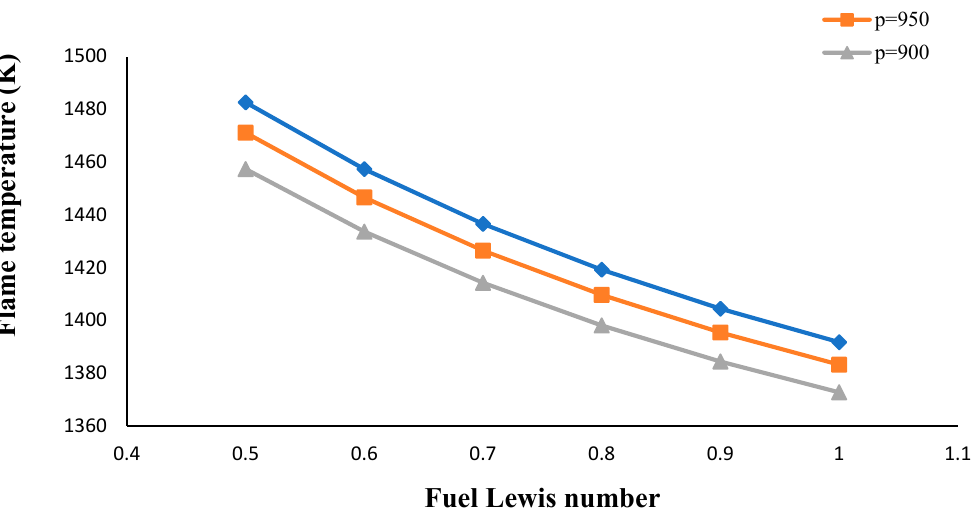
Figure 8. Flame temperature against the fuel Lewis number for several values of mass particle concentration.